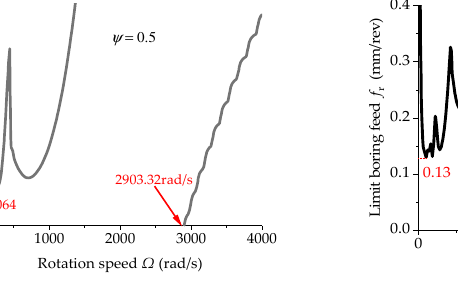
TR = 1 TR = 2 Figure 16. Effect of the taper ratio on the stability of the boring bar ( ψ = 1 and L = 2 m). Figure 17 shows the effect of the ply angle on the cutting stability of the uniform- section boring bar with a length of 2 m. Through comparison, as the number of 0° plies